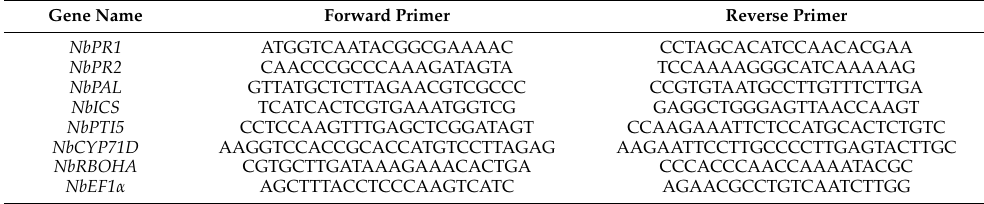
Table 1. Primers used for RT-qPCR of defense-related and internal control